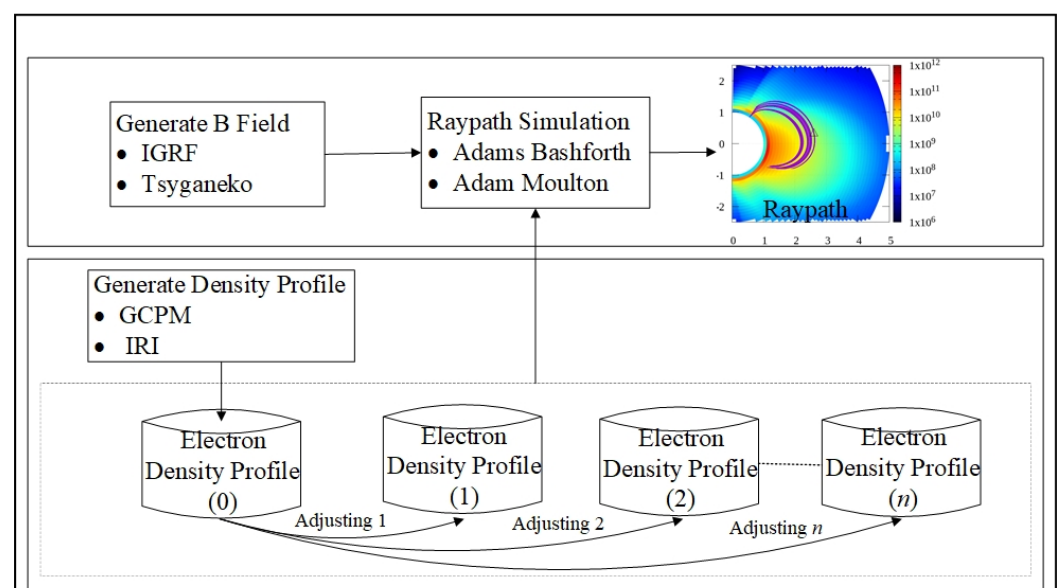
Figure 3. Flowchart of the ray tracing simulation system.